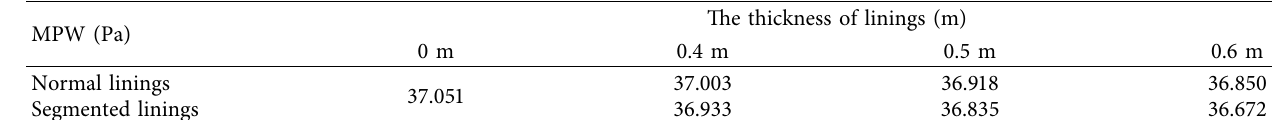
Table 7: Comparison of amplitude values of the micropressure wave at M